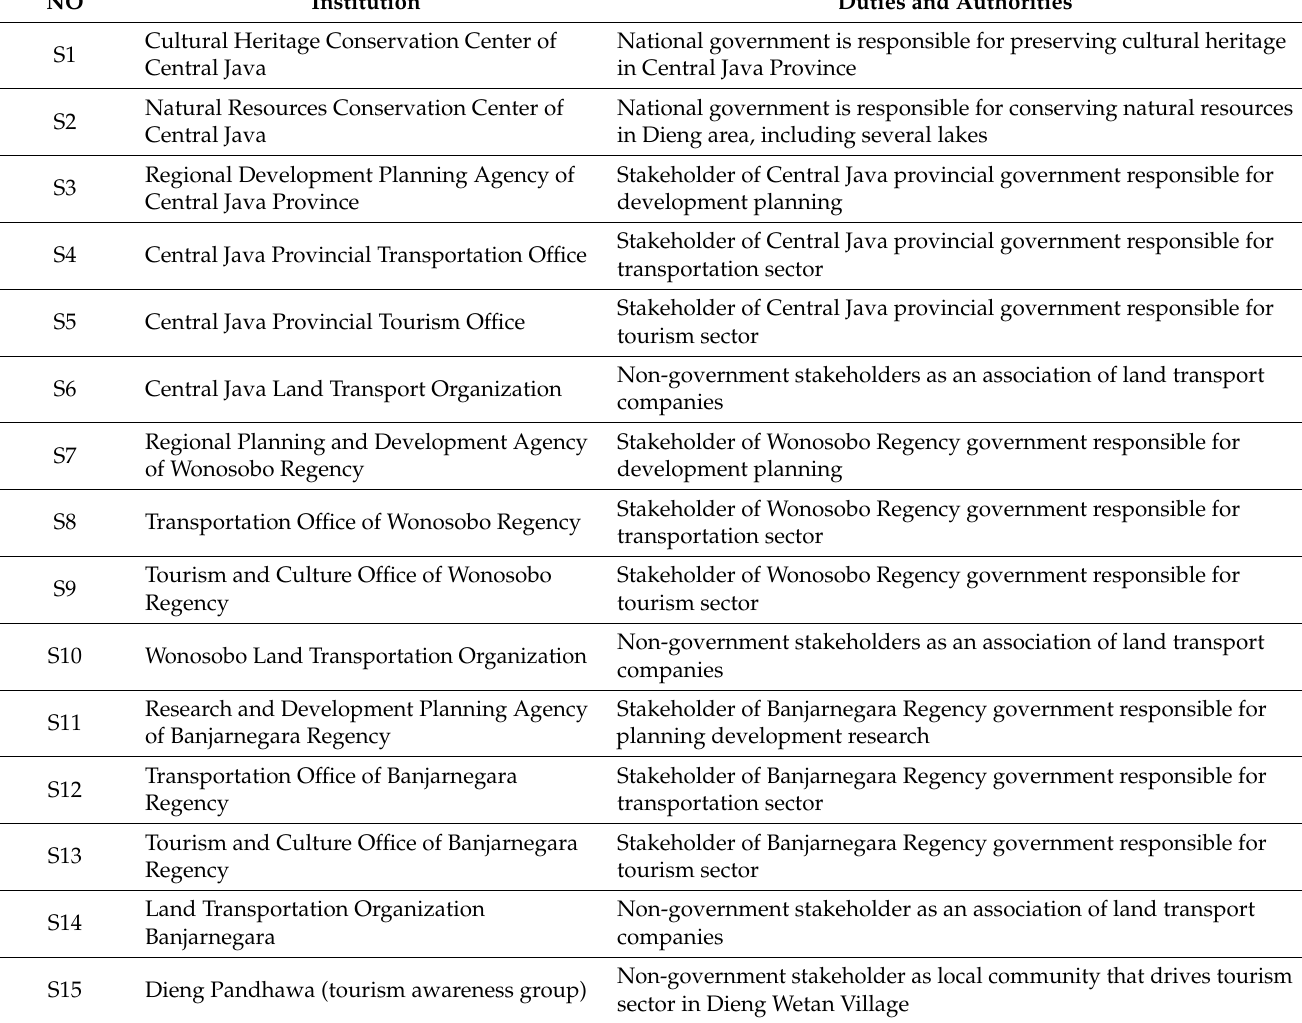
Table 2. Stakeholders related to transportation policies in natural and cultural tourism